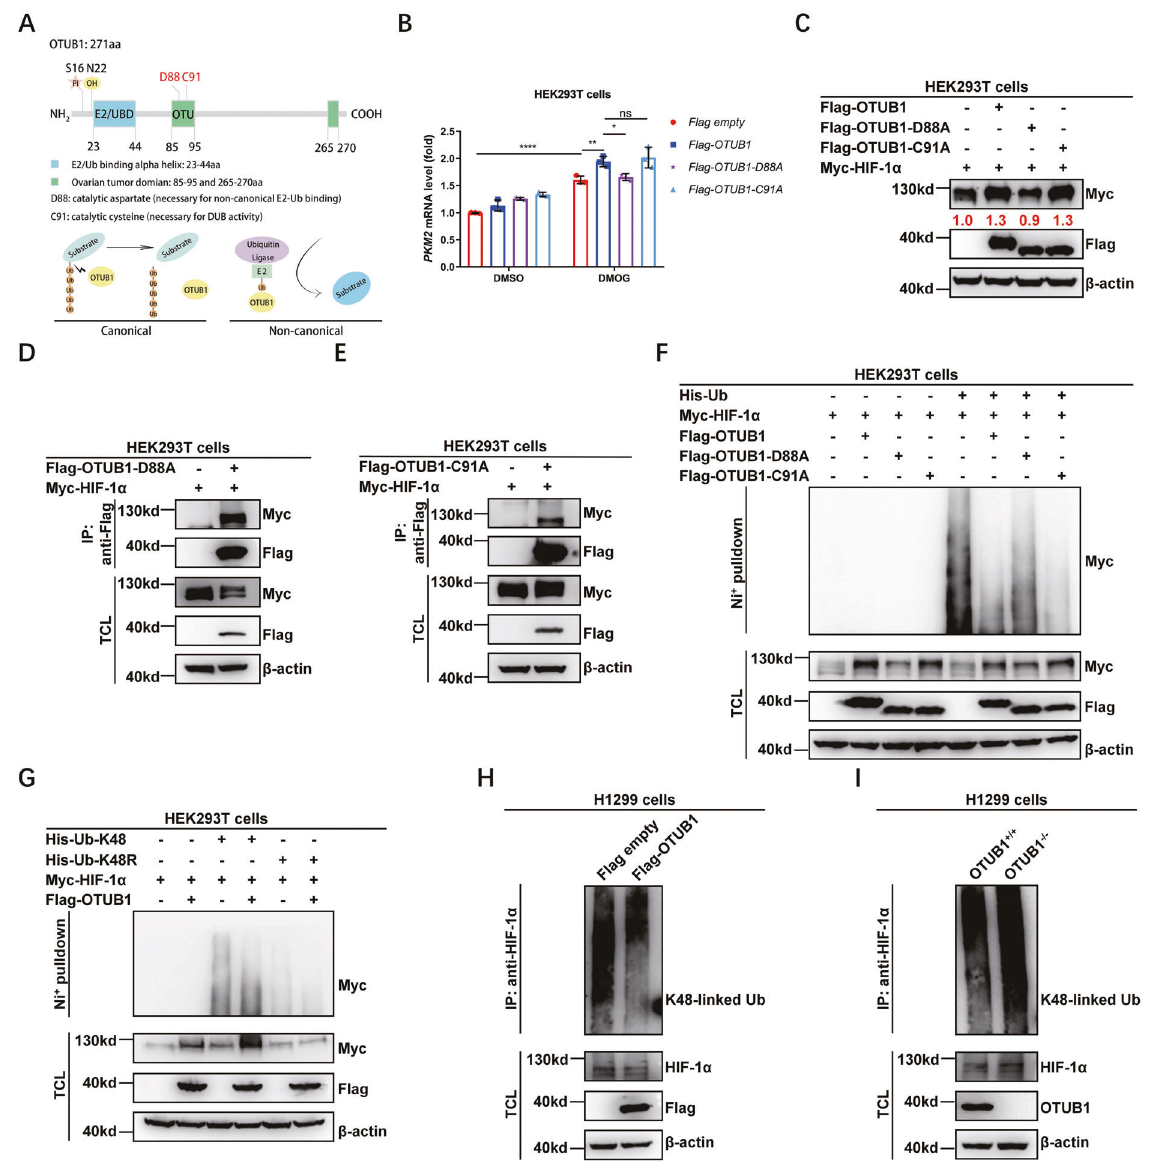
Fig. 6 OTUB1 inhibits K48-linked polyubiquitination of HIF-1 α dependent of its non-canonical activity. A Schematic of the domain architecture of OTUB1, showing its E2-binding/ubiquitin binding domain (UBD) region (E2-UBD), ovarian tumor domain (OTU), catalytic sites and modi fi cation sites. The working model shows the canonical enzymatic activity and non-canonical activity mediated by OTUB1. B qPCR analysis of PKM2 mRNA in HEK293T cells transfected with Flag-OTUB1 or its mutants with the treatment of DMSO (as a control) or DMOG (1 mM) for 6 h. Flag empty vector was used as a control. Two-way ANOVA analysis; Data show mean ± SD; Tukey ’ s multiple comparisons test; ns, not signi fi cant, ****Adjusted p < 0.0001; Data from 3 independent experiments. C Immunoblotting of exogenous Myc-HIF-1 α expression in HEK293T cells transfected with expression plasmid encoding Flag-OTUB1 or its enzymatically de fi cient mutants. D Co-immunoprecipitation of Flag-OTUB1-D88A with Myc-HIF-1 α . HEK293T cells were co-transfected with indicated plasmids for 24 h. Anti-Flag antibody-conjugated agarose beads were used for immunoprecipitation, and the interaction was detected by immunoblotting with the indicated antibodies. E Co- immunoprecipitation of Flag-OTUB1-C91A with Myc-HIF-1 α . HEK293T cells were co-transfected with indicated plasmids for 24 h. Anti-Flag antibody-conjugated agarose beads were used for immunoprecipitation, and the interaction was detected by immunoblotting with the indicated antibodies. F HIF-1 α ubiquitination in HEK293T cells transfected with Myc-HIF-1 α , His-Ub (His empty vector was used as a control), together with Flag-OTUB1, Flag-OTUB1-D88A or Flag-OTUB1-C91A (Flag empty vector was used as a control) for 24 h. G HIF-1 α ubiquitination in HEK293T cells transfected with indicated plasmids for 24 h. H Endogenous HIF-1 α ubiquitination in H1299 cells transfected with indicated plasmids for 24 h, followed by MG-132 (20 μ M) treatment for 6~8 h. I Endogenous HIF-1 α ubiquitination in WT or OTUB1 -de fi cient H1299 ( OTUB1 + / + or OTUB1 − / − ) cells treated with MG-132 (20 μ M) for 6~8 h. hypoxia, the maximal respiration and spare respiratory capacity of It has been well-established that HIF-1 is a master regulator for OTUB1 − / − H1299 cells was higher than that of OTUB1 + / + H1299 cells metabolic adaptation under hypoxia [72 – 74]. Subsequently, we compared the oxygen consumption rate between wildtype (Fig. 7I – J). We next determined the effect of OTUB1 on glycolysis via ( OTUB1 + / + ) and OTUB1 -de fi cient H1299 ( OTUB1 − / − ) cells under the proton ef fl ux rate measurement. Loss of OTUB1 in H1299 cells led to decreased compensatory glycolysis signi fi cantly compared to normoxia or hypoxia based on mitochondrial stress test. Under Cell Death and Disease (2022)